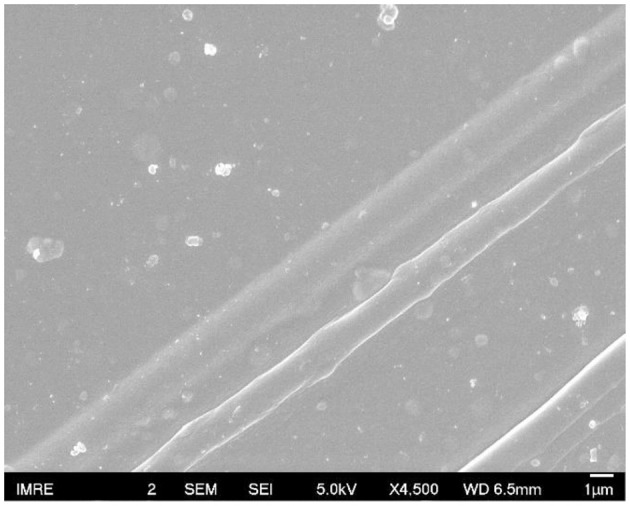
FESEM micrograph of 3% DMSO2 in PEDOT:PSS.